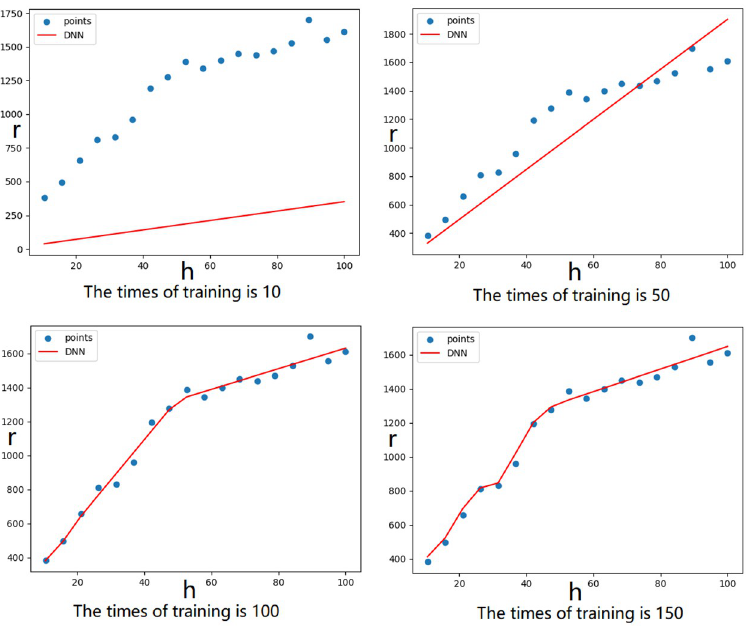
Fig 5. The results of different semivariogram functions in the four areas.